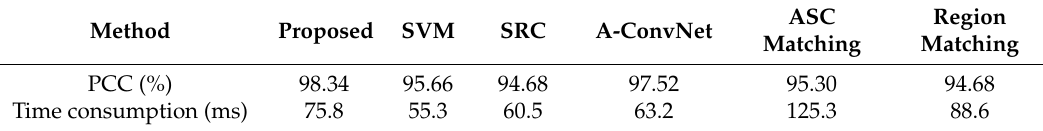
Table 4. Average PCCs of all the methods under the standard operating